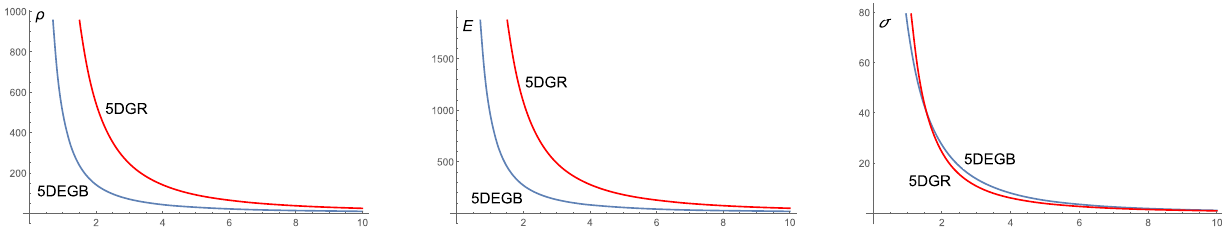
Fig. 4 Energy density ρ , electrostatic field intensity E and proper charge density σ versus radius x for the 5D EGB case ( β = 1 case ( β =